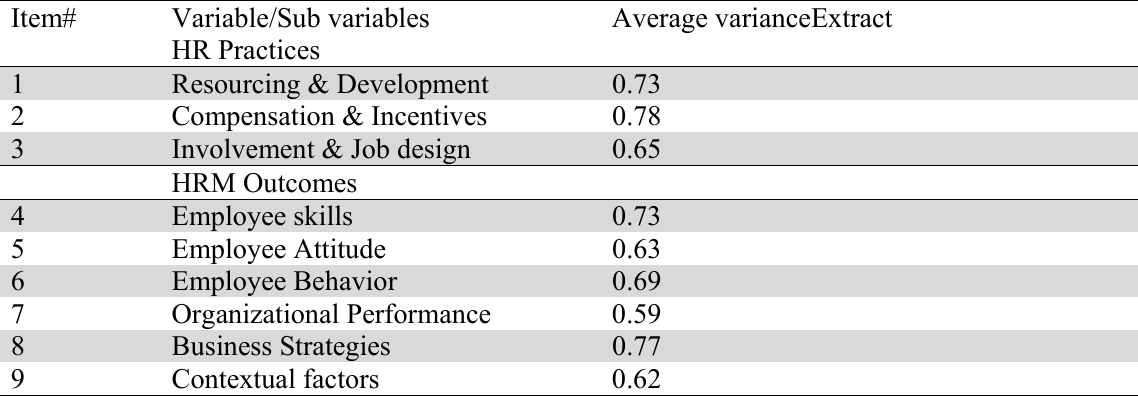
Average Variance